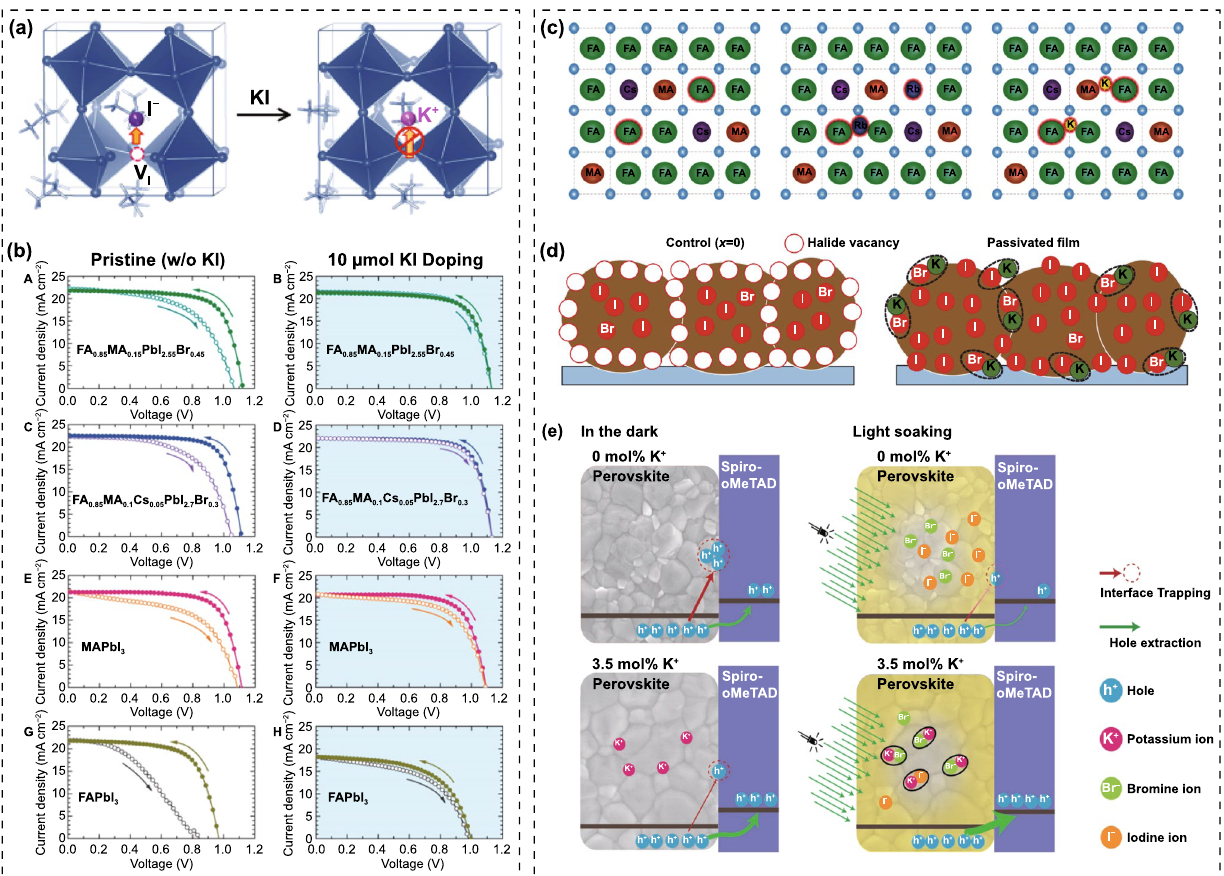
Fig. 7 a Schematic of the Frenkel defect passivated by K + . b Current–voltage curves of PSCs employing different perovskite materials with and without K + doping. Reproduced with permission from Ref. [128]. Copyright 2018, American Chemical Society. c Schematics of the doping mechanism of Cs/MA/FA perovskite doped with Cs + , Rb + , and K + . Reproduced with permission from Ref. [129]. Copyright 2018, Wiley–VCH. d Schematic of the passivation mechanism of K + , in which the surplus halide is immobilized through complexing with potassium into benign compounds at the grain boundaries and surfaces. Reproduced with permission from Ref. [130]. Copyright 2018, Nature Publishing Group. e Schematic of the passivation effect of K + -doped perovskite under illumination. Reproduced with permission from Ref. [132]. Copyright